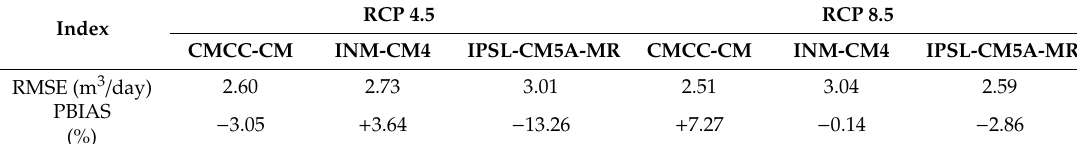
Table 4. The statistical results of dam inflow with the selected climate change scenarios applied.